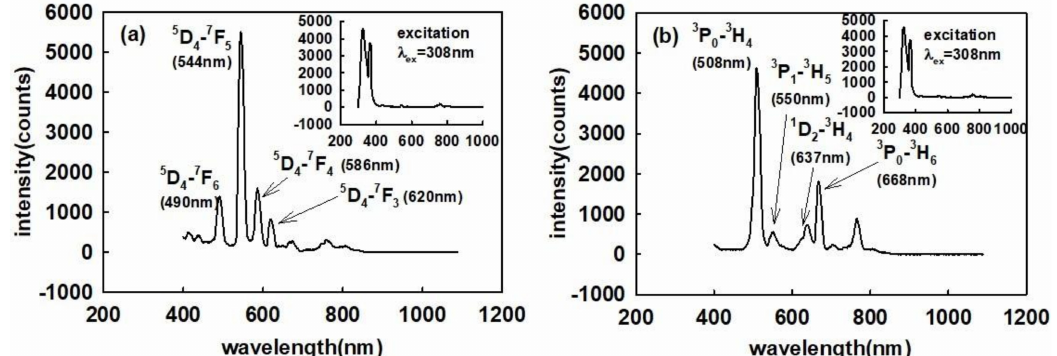
Figure 5. The emission spectra of the Gd 2 O 2 S ( a ) doped with Tb ( b ) doped with